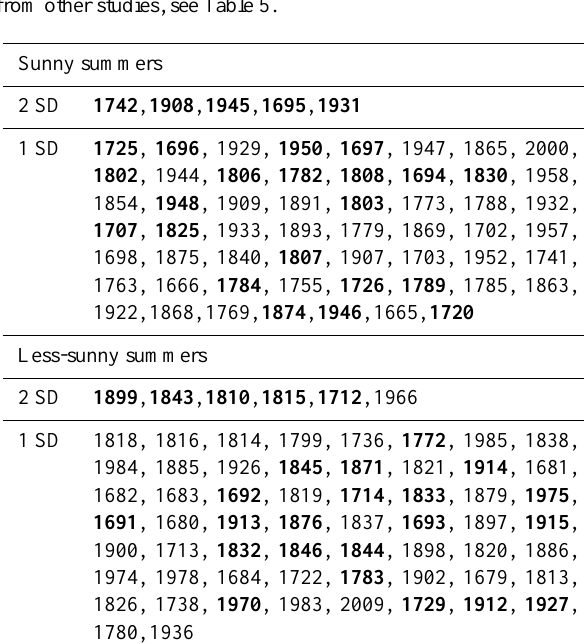
Table 4. List of years with extreme summers, aligned from the years with the highest standard deviation (SD) from the mean to years, closer to mean value. Event years in bold are common to results from other studies, see Table